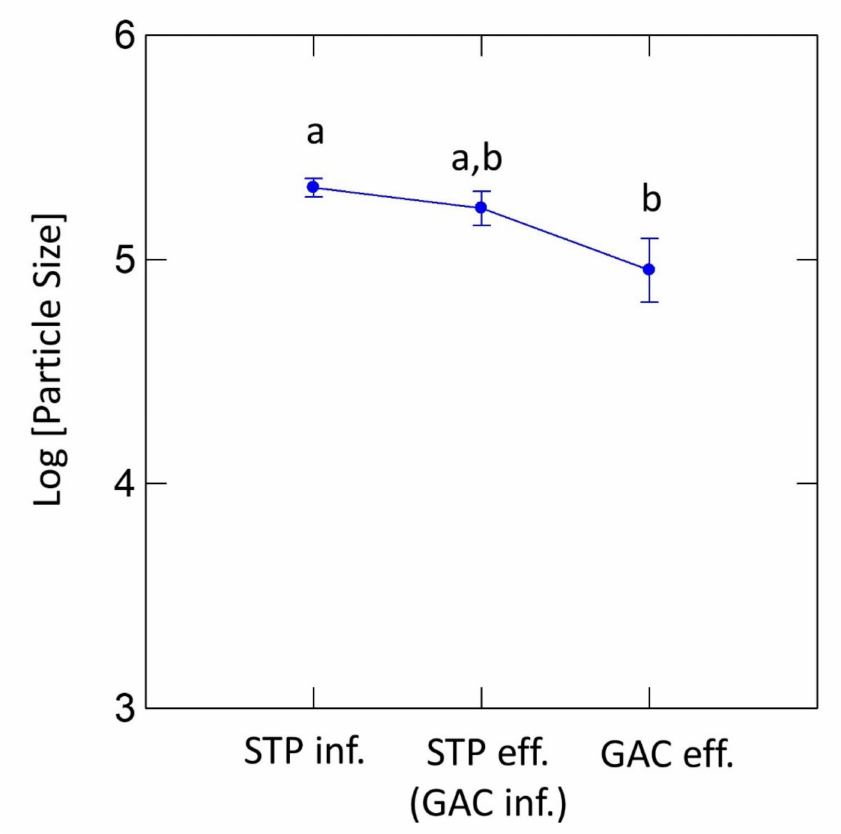
Figure 5. Size distributions of MP particles at different stages. Different letters indicate significant differences in MP sizes (one-way ANOVA with a least significant difference (LSD) post hoc test). Error bars indicate 1 standard deviation.